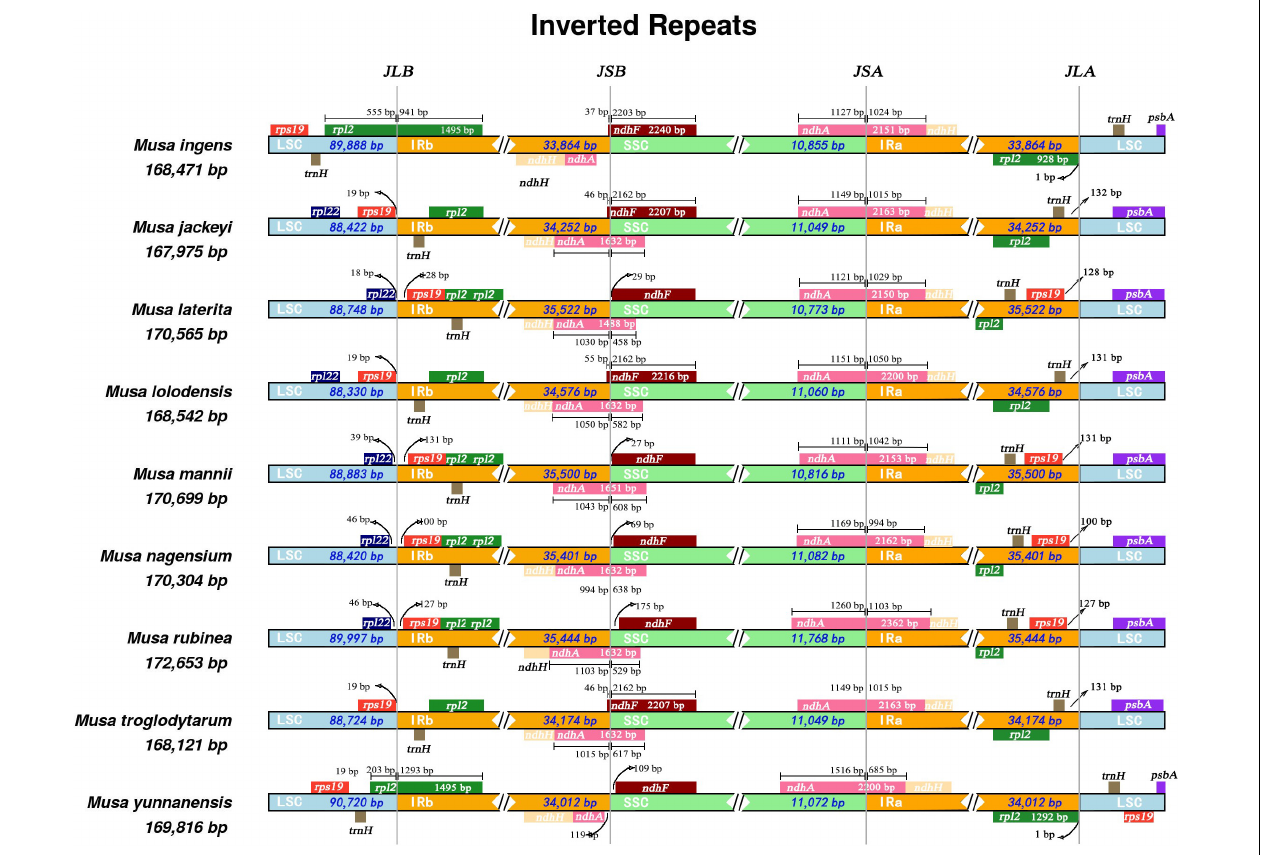
FIGURE 2 | Comparison of SSC, LSC, IRB, and IRB boundary regions in the chloroplast genomes of nine species of Musa . Comparative analysis of junction sites in Musa chloroplast genomes. The coordinate position of the start or end of each gene from the corresponding junction is shown with arrows. All the genes those integrate from one region of chloroplast genome to another region are shown with the T bar above or below. The T bars show the length of base pair for which the integration of genes has been occur. JLA (IRa/LSC), JLB (IRb/LSC), JSA (SSC/IRa), and JSB (IRb/SSC) denote the junction sites between each corresponding two regions on the